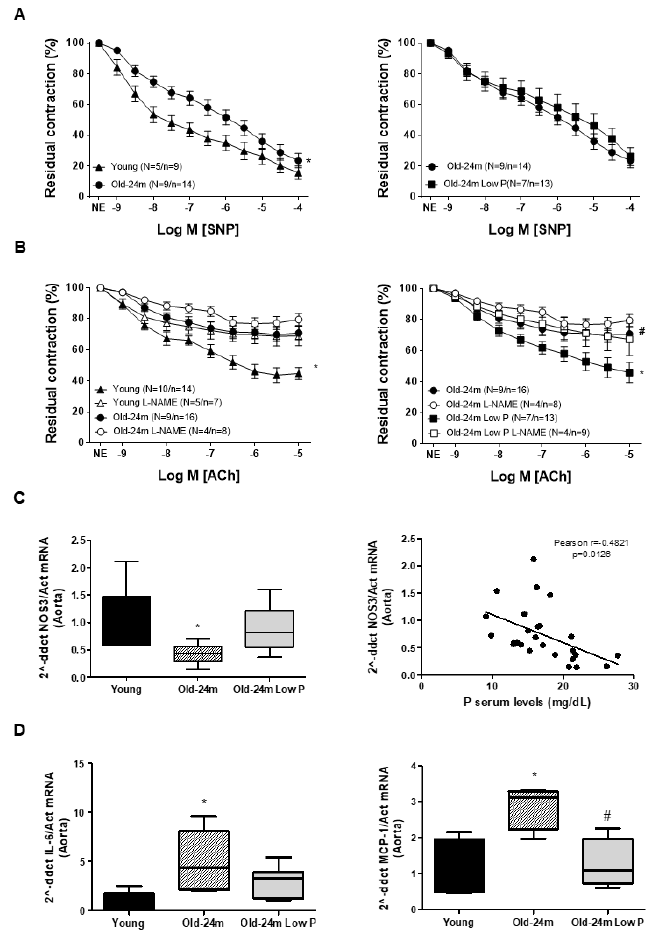
Figure 1. Hyperphosphatemia reduces endothelium-dependent vascular relaxation in old mice by reducing NOS3 expression and increases vascular inflammation. Male C57Bl6 mice from 5 month old (Young, closed triangle), 24 month old fed with normal diet (Old-24 m, closed circle) and 24 month old mice fed with a low phosphate diet for the last 3 months of life (Old-24 m Low P, closed square) were used. Vascular reactivity was measured in mesenteric arteries from those mice ( A , B ). Vascular relaxation in response to SNP are shown in panel A, comparing Young with Old mice on the left panel A and comparing Old-24 m with Old-24 m low P mice on the right panel A. N indicates the number of animals measured, and n denotes the number of segments analyzed. ( B ) Vascular relaxation in response to ACh was measured in the presence of inhibitor of NOS3, L-NAME 100 µ M (open symbols) or in the absence of L-NAME (closed symbols). Young versus Old mice on the left panel B are compared with or without L-NAME treatment, and old mice fed with standard diet on the right panel B are compared with respect to old mice fed with a low P diet, with or without L-NAME. ( C ) On the left panel, NOS3 expression by real-time PCR of the aorta tissue from those mice is shown, and on the right the graph of correlation between P serum levels and NOS3 expression in aorta is shown (Pearson r = − 0.6034, p = 0.0018). ( D ) IL-6 and MCP-1 expressions were analyzed in aorta by real-time PCR. Values are the mean ± SEM of 10 mice per group, * p < 0.05 vs. the other groups, # p < 0.05 compared Old-24 m vs. Old-24 m Low P.